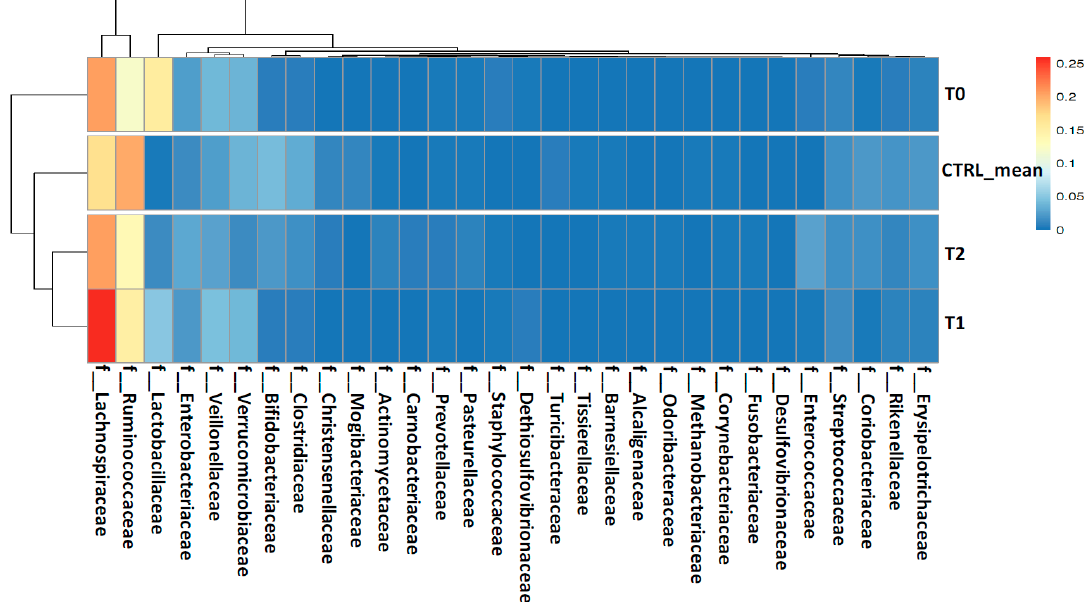
Figure 4. Heatmap with hierarchical clustering based on families’ (L5) abundances. The colors in the heatmap refer to the family’s abundance, according to the color scale on the right.